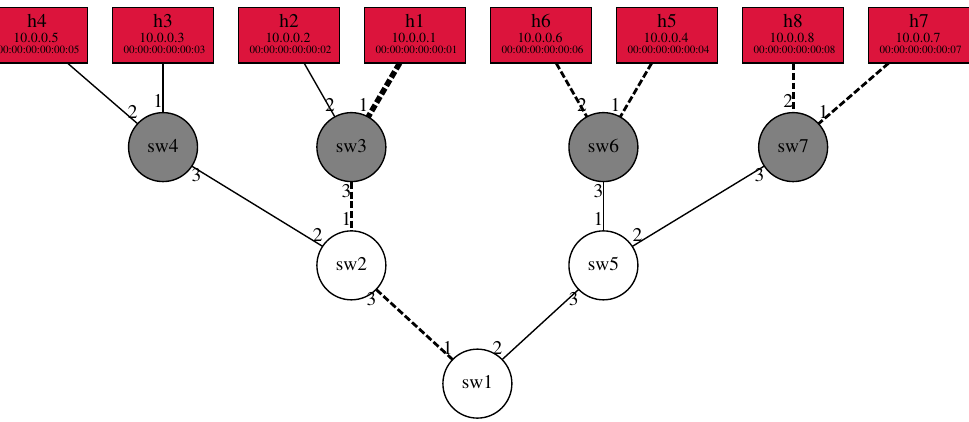
Figure 13. The framework successfully identified switch sw1 as the first point where issues occur in the configuration error use-case. Marking host h1 as the most problematic one (see thick dashed line) helps in later analysis at switch sw1 .